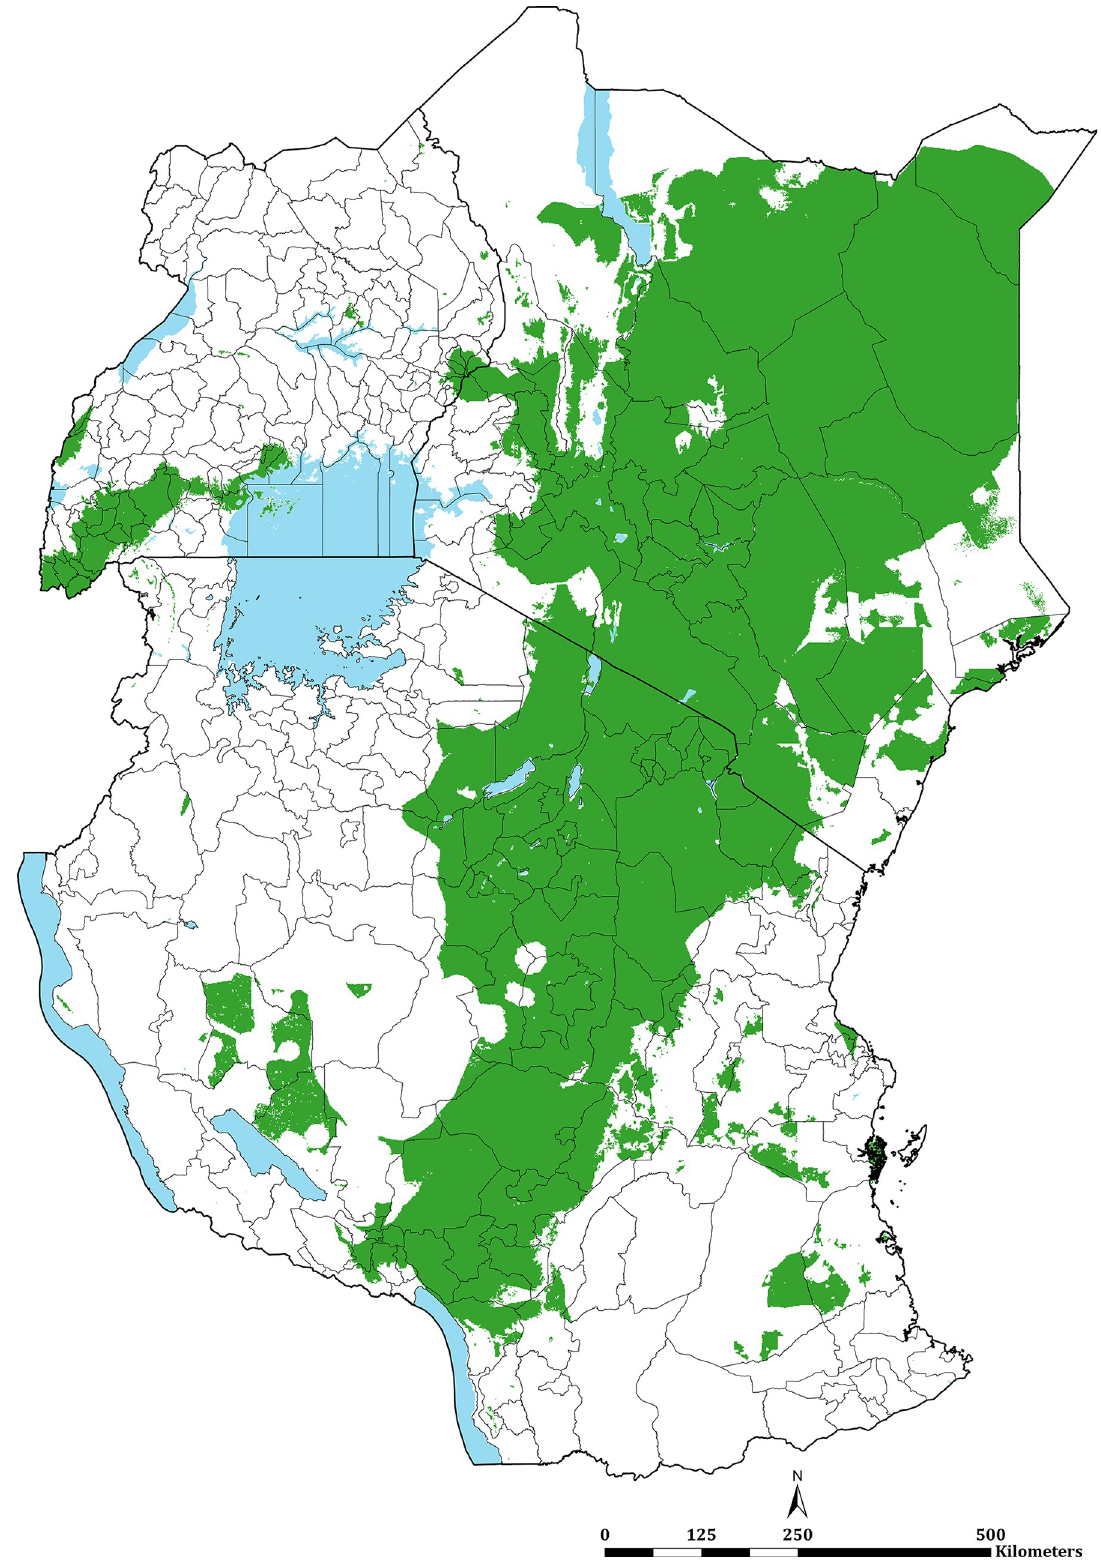
Fig 5. Non-exceedance probability (NEP) maps for 2019. PA Pf PR 2-10 predictions are 90% certain to be < 1%, shown in green. Derived from the fitted spatiotemporal model, formally expressed as: NEP = (Prob PA Pf PR 2–10 (x, t) < l|Data); where l is the